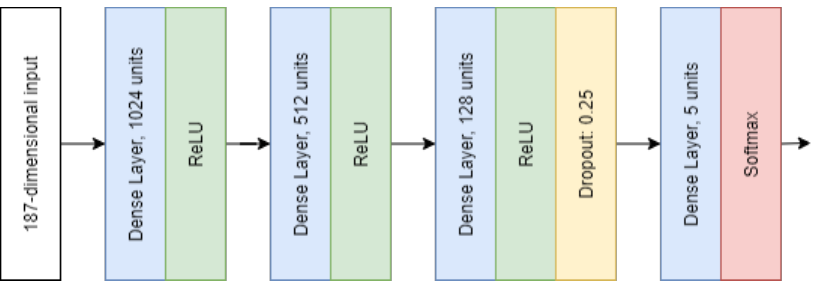
Figure 7. Neural network architecture used for teachers and student in the ECG example.